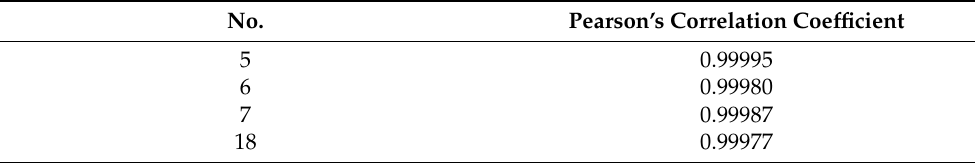
Table 2. Results of the correlation analysis between the IVTs and battery